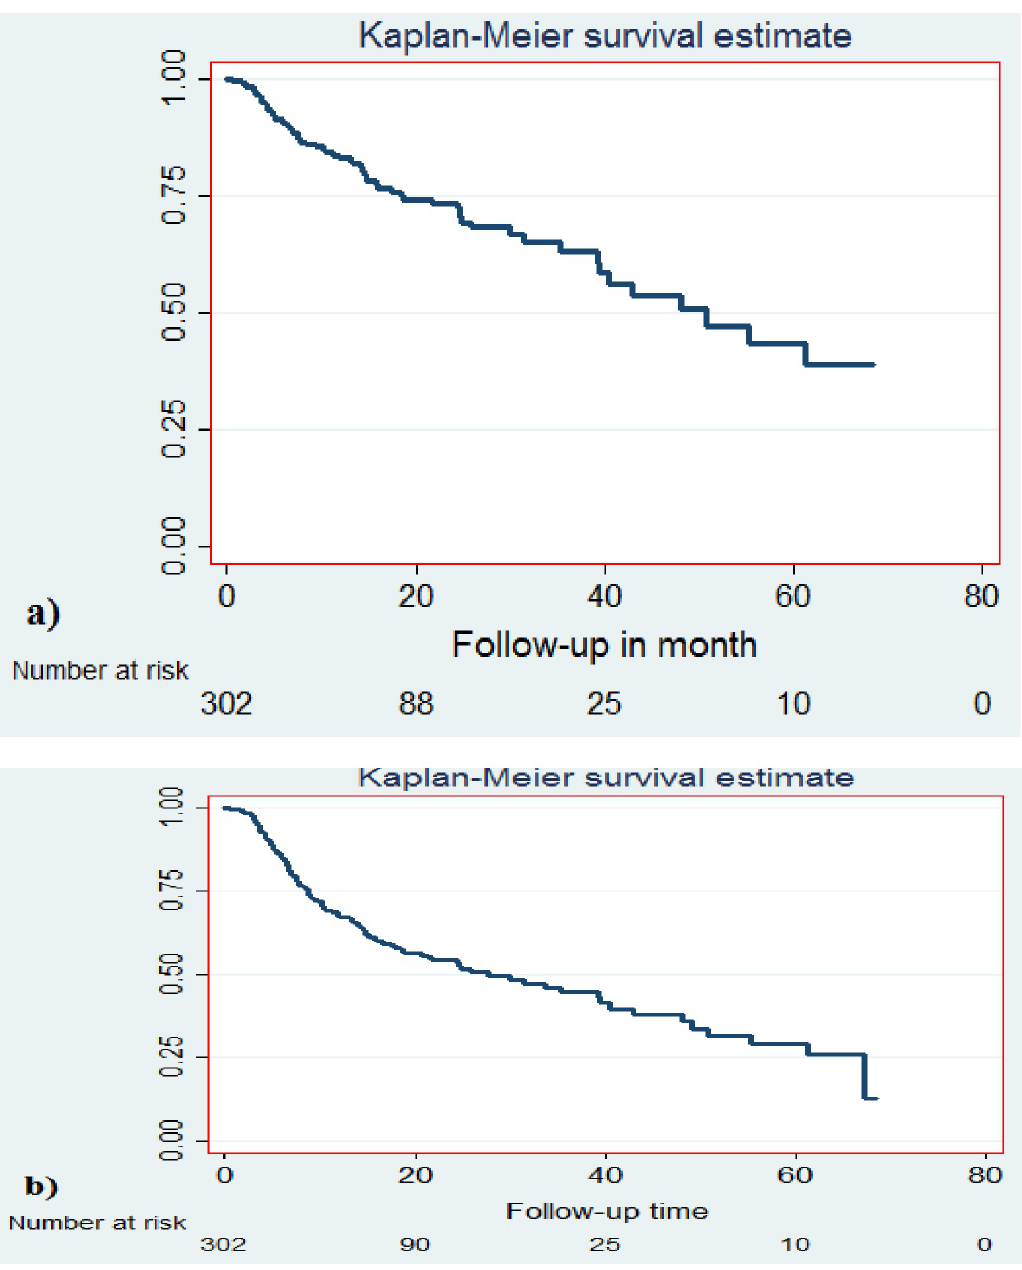
Fig 2. Kaplan-Meir survival curve showing time to death among female breast cancer patients in South Ethiopia, 2013–2018. (a) Main analysis (b) Worst-case